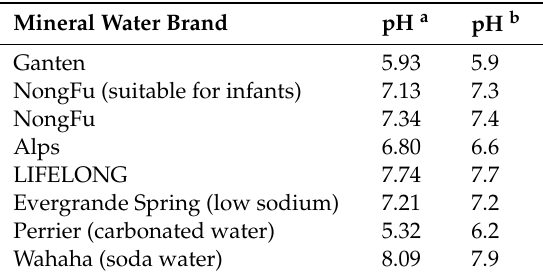
Table 1. Measurement of pH in mineral water samples.